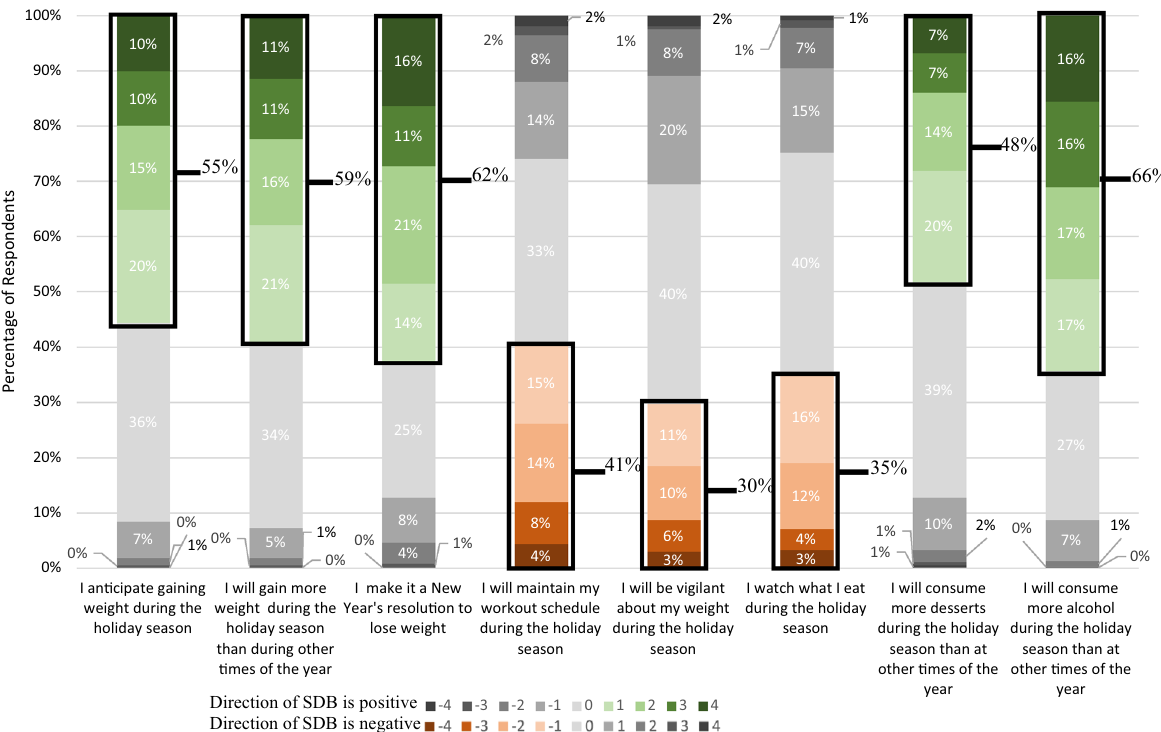
Fig. 2 Holiday SDB control sample n = 367. Exhibits SDB is de fi ned as having a score of less than − 1 or >1, depending on the statement. Black boxes indicate the direction of SDB, therefore the percentage of respondents who indicated SDB can be determined by adding the percentages within the box for that question. For example for the statement “ I anticipate gaining weight during the holiday season ” , the percentage who exhibit SDB can be calculated by adding 10 + 10 + 15 + 20 = 55, and is given to the right of the